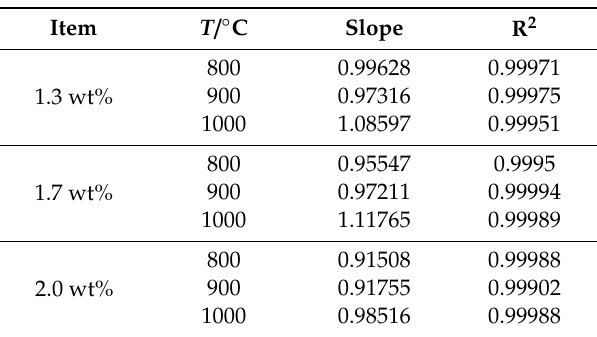
Table 4. Slope of linear fitting and R 2